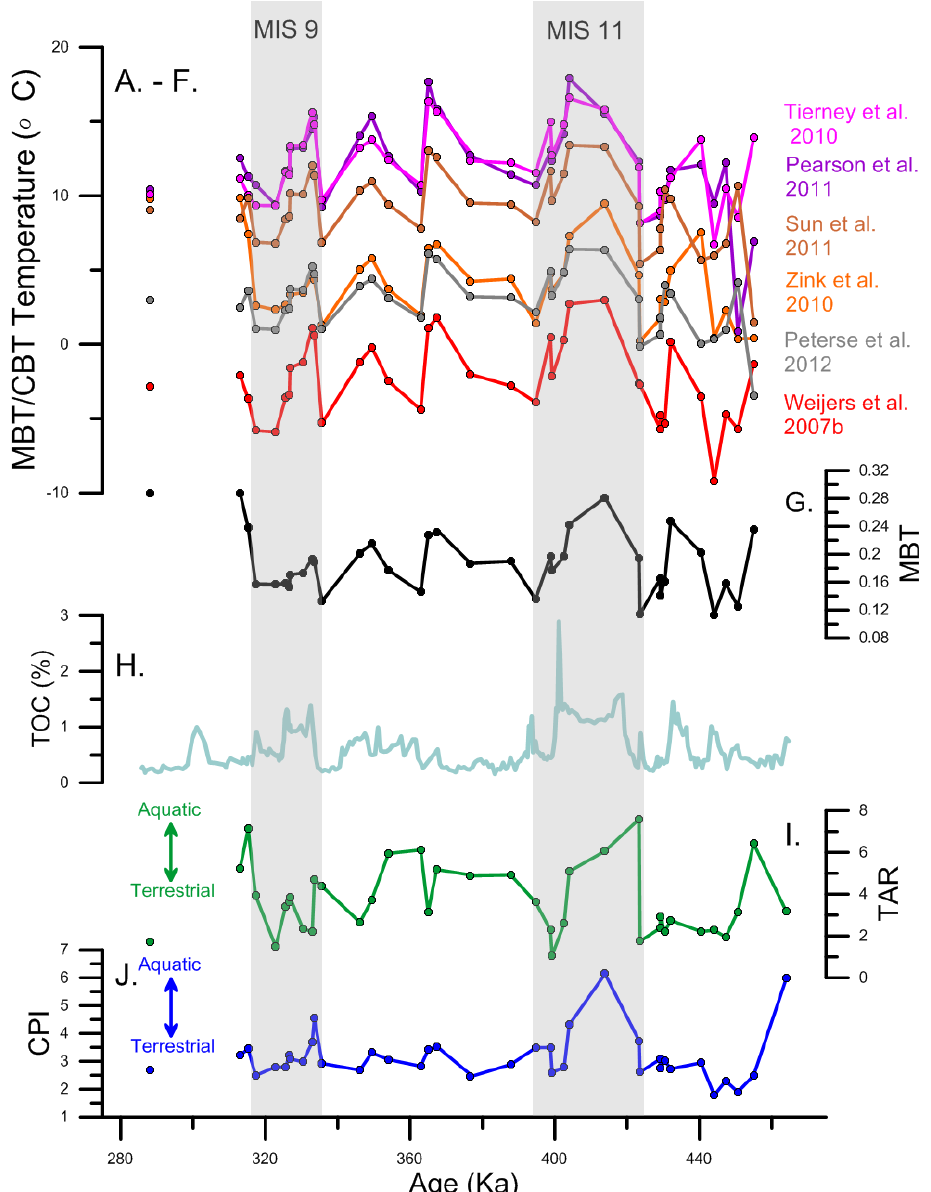
Fig. 3. ( a through j ) MBT/CBT Temperature ( ◦ C) calculated from brGDGTs based on calibrations of (a) Weijers et al. (2007b); (b) Tierney et al. (2010); (c) Pearson et al. (2011); (d) Sun et al. (2011); (e) Zink et al. (2010) and (f) Peterse et al. (2012). (g) MBT values; (h) TOC data; (i) TAR values, where the arrow indicates increased terrestrial input and (j) CPI values, where the arrow indicates increased terrestrial input and/or OM preservation. Gray bars indicate the timing of MIS 9 and MIS 11 interglacial periods.